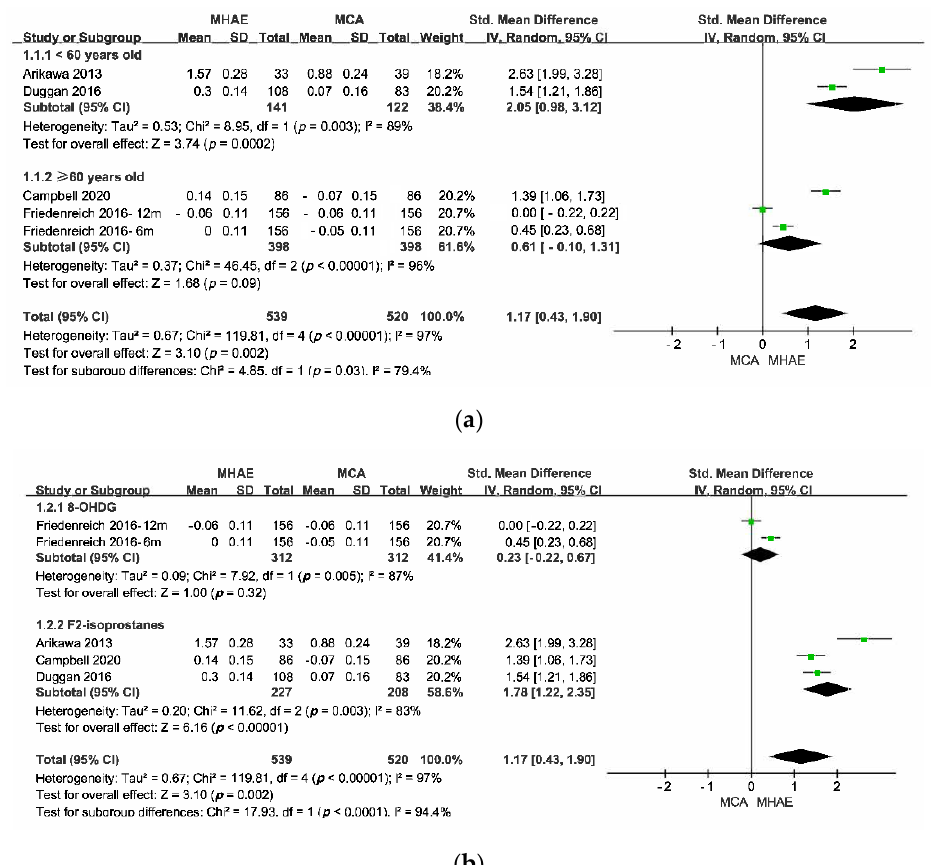
Figure 4. The results of the pair-wise meta-analysis. ( a ) Divided by the age of participants; ( b ) divided by outcome measures.